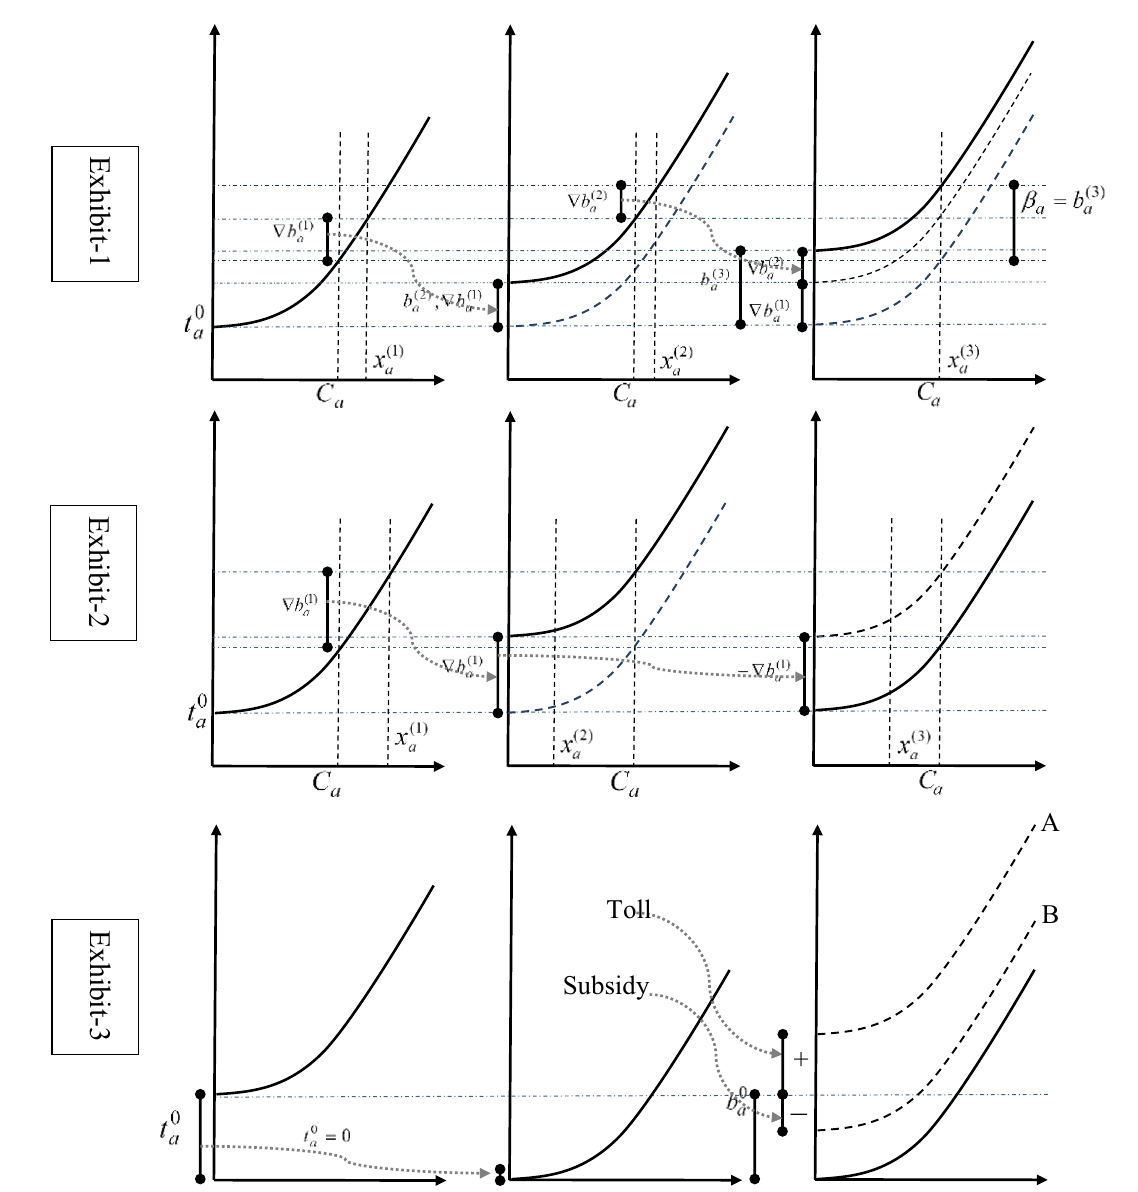
Fig. 1 Conceptual representation of the proposed methodology for the road delay